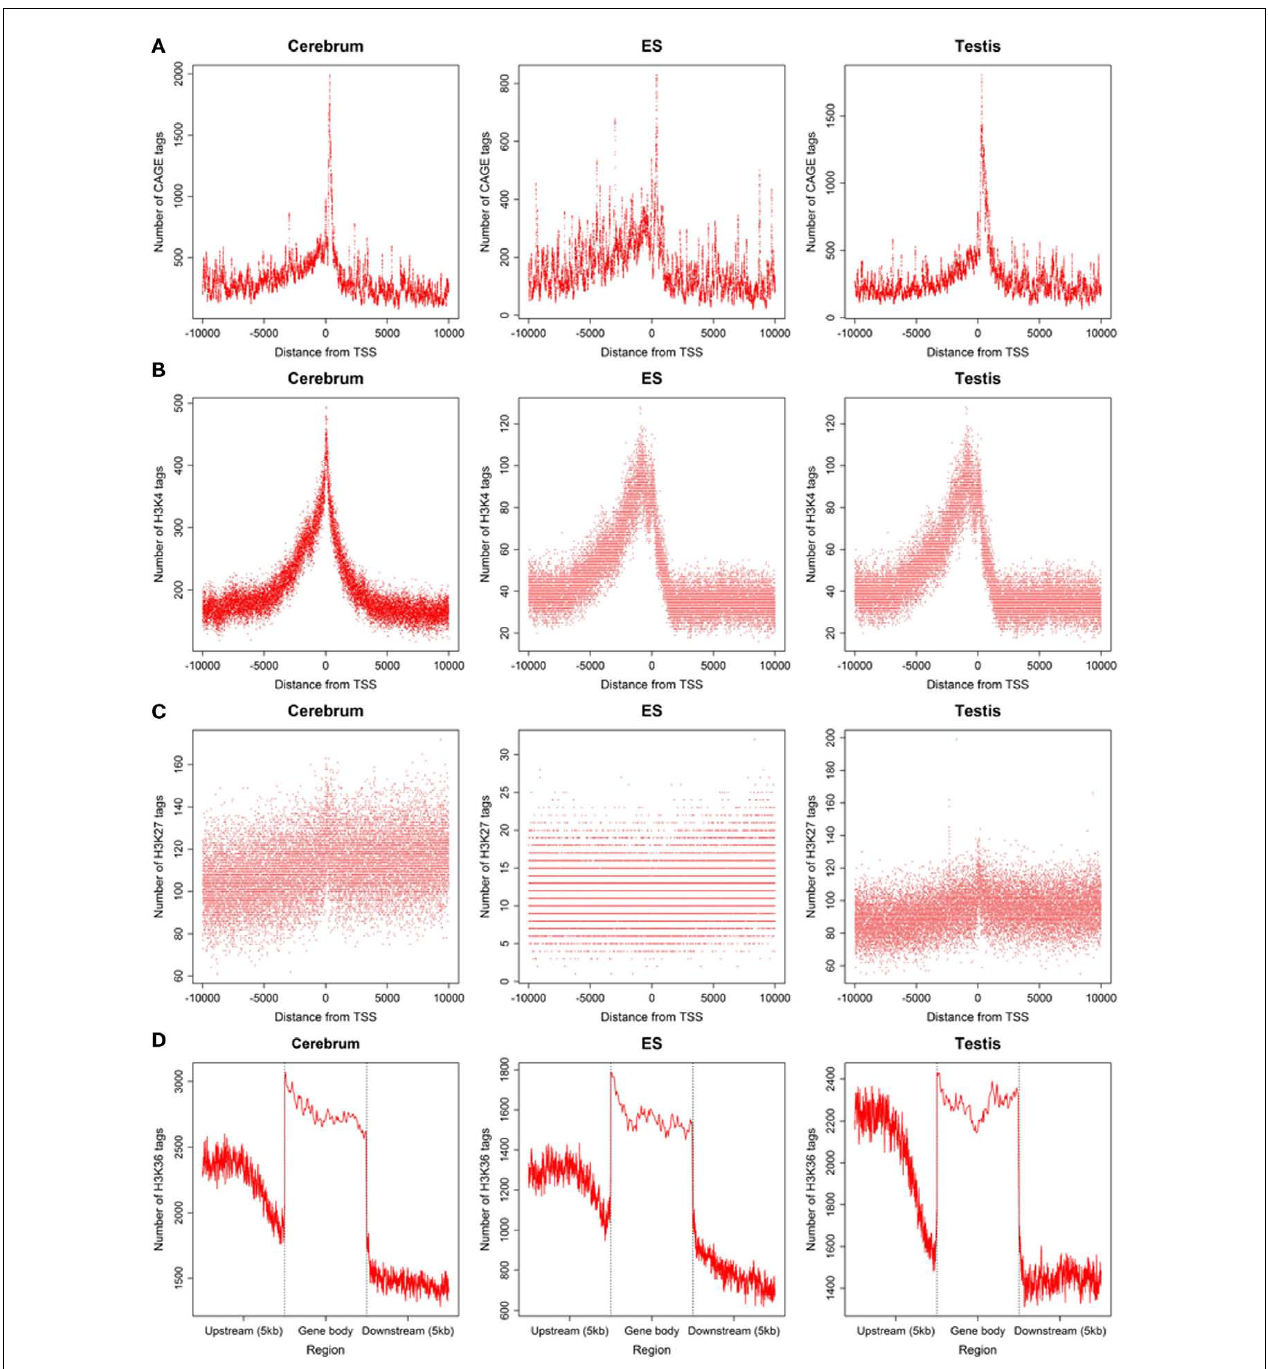
FIGURE 4 | 5 (cid:2) CAGE and histone modification around novelTU–TSS or gene bodies in the mouse cerebrum, testis, and ES cell. (A–D) Profiles of 5 (cid:2) CAGE, H3K4me3, H3K27me3, and H3K36me3 .